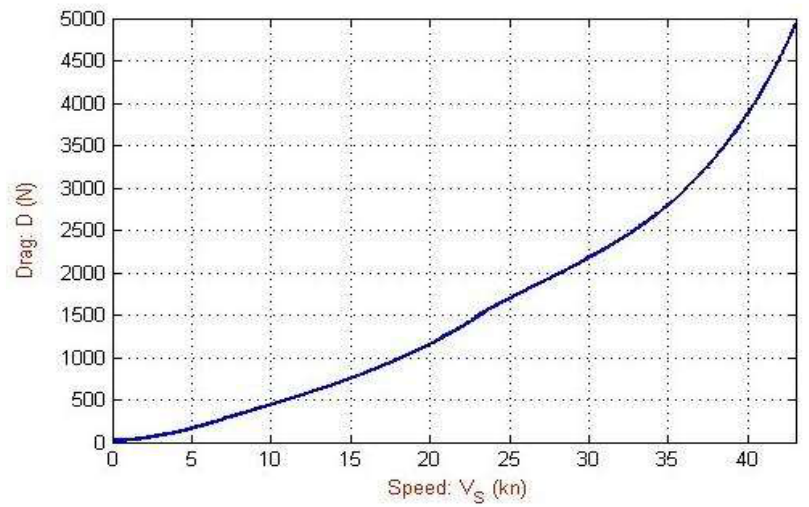
Figure 15. Resistance (drag) versus speed, according to the Savitsky general case method.